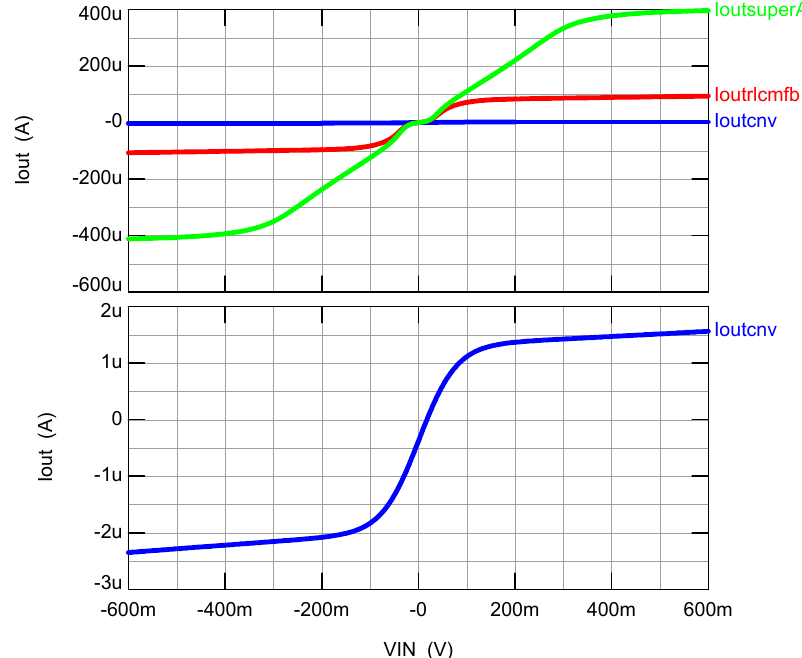
Figure 11. Transconductance characteristics of conventional OTA of Figure 3a (blue trace), RLCMFB OTA of Figure 3b (red trace) and super class AB OTA of Figure 10 (green trace).